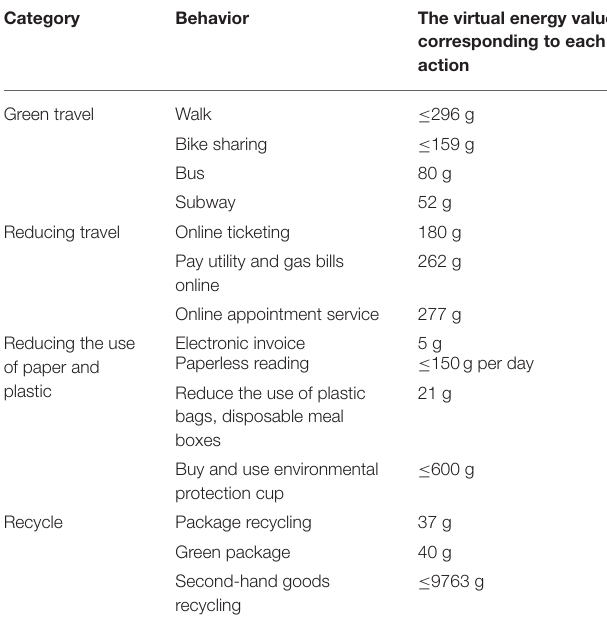
TABLE 1 | The virtual energy value corresponding to the offline sustainable consumption